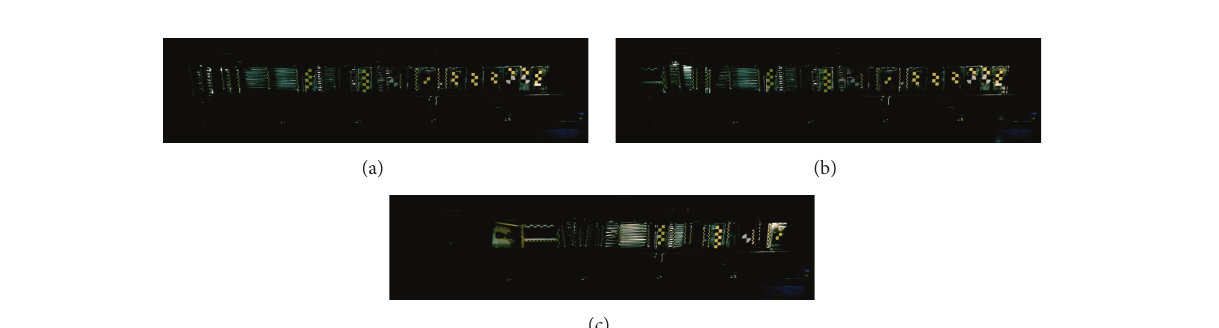
Figure 5: Impact process recorded by high-speed camera: (a) before collision; (b) during collision; (c) after